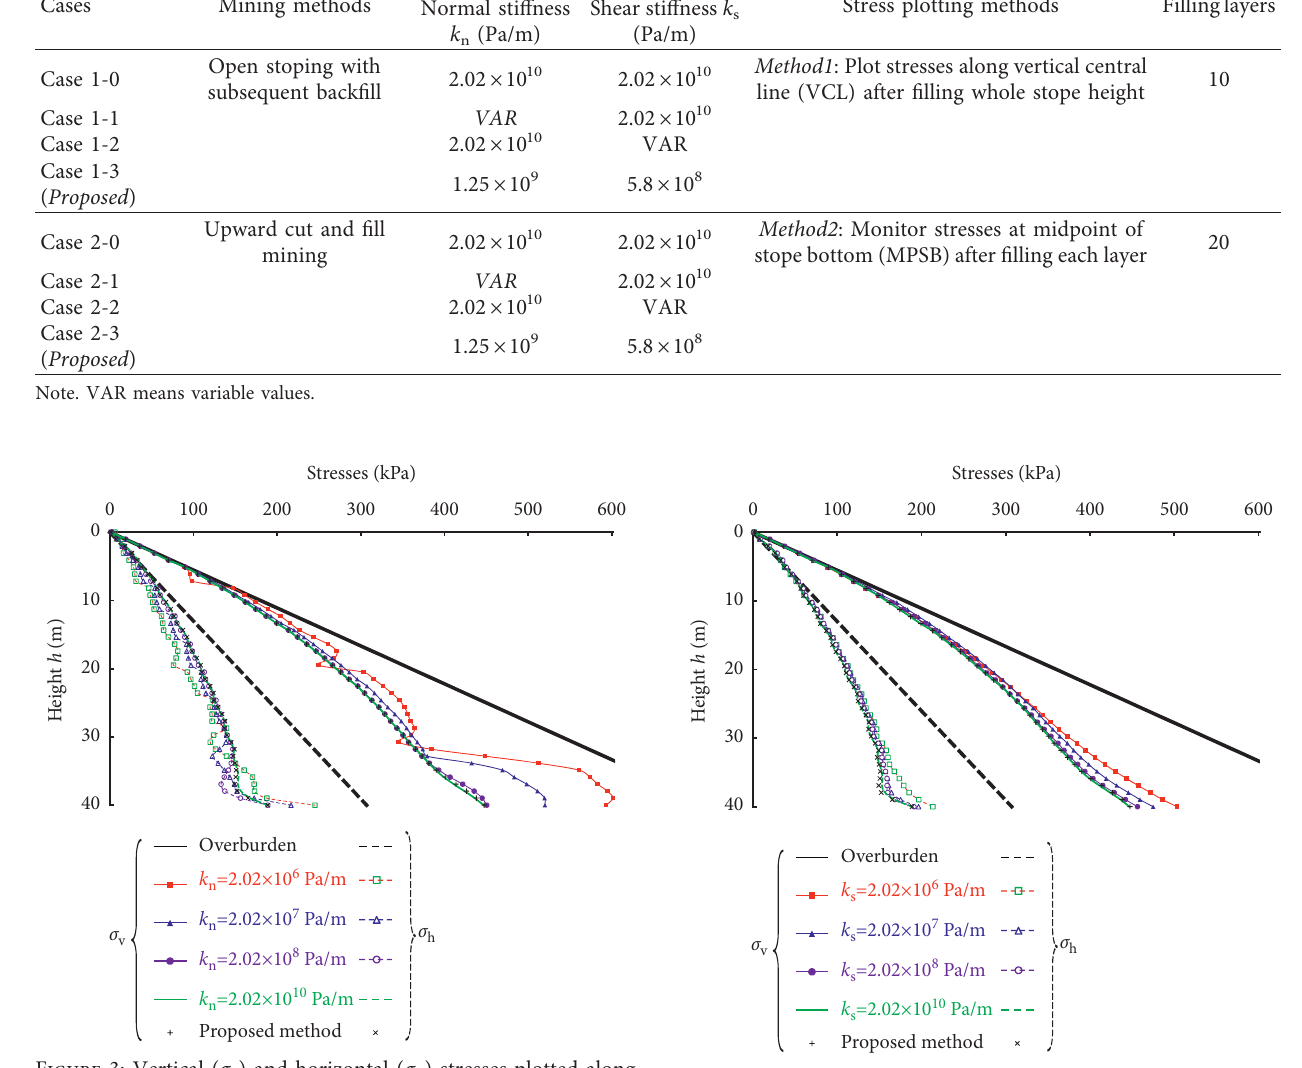
Figure 4: Vertical ( σ v ) and horizontal ( σ h ) stresses plotted along VCL of stopes with different shear stiffness (k) s of interfaces in open stoping with subsequent backfill